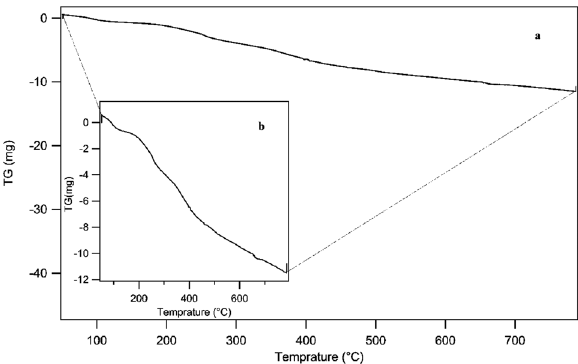
Figure 9: Thermogravimetric analysis of: (a) MMNP and (b) magnification of MMNP thermogravimetric analysis.